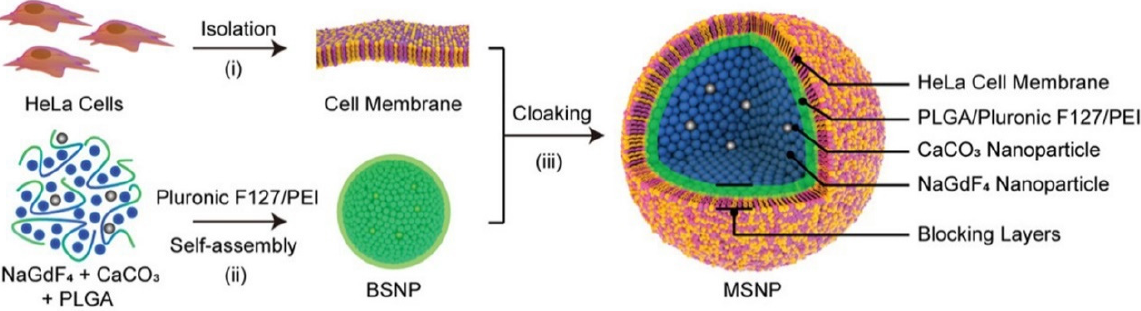
Figure 2. Schematic illustration of the prepared CaCO 3 NPs for MRI. Reprinted with permission. Copyright 2019, Wiley-VCH [27].